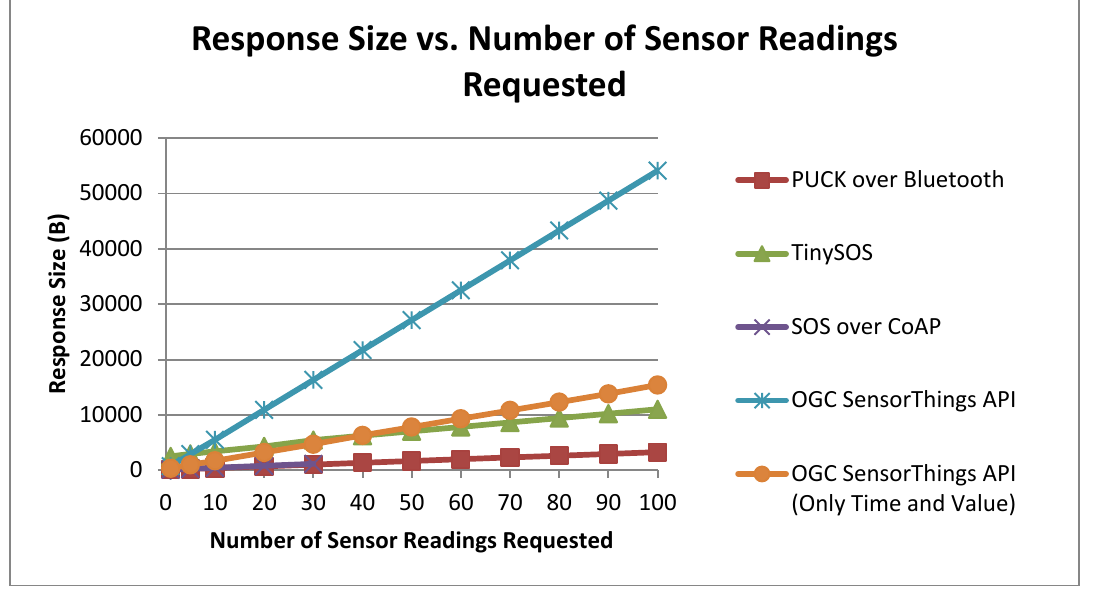
Figure 12. Response size vs. the number of sensor readings.